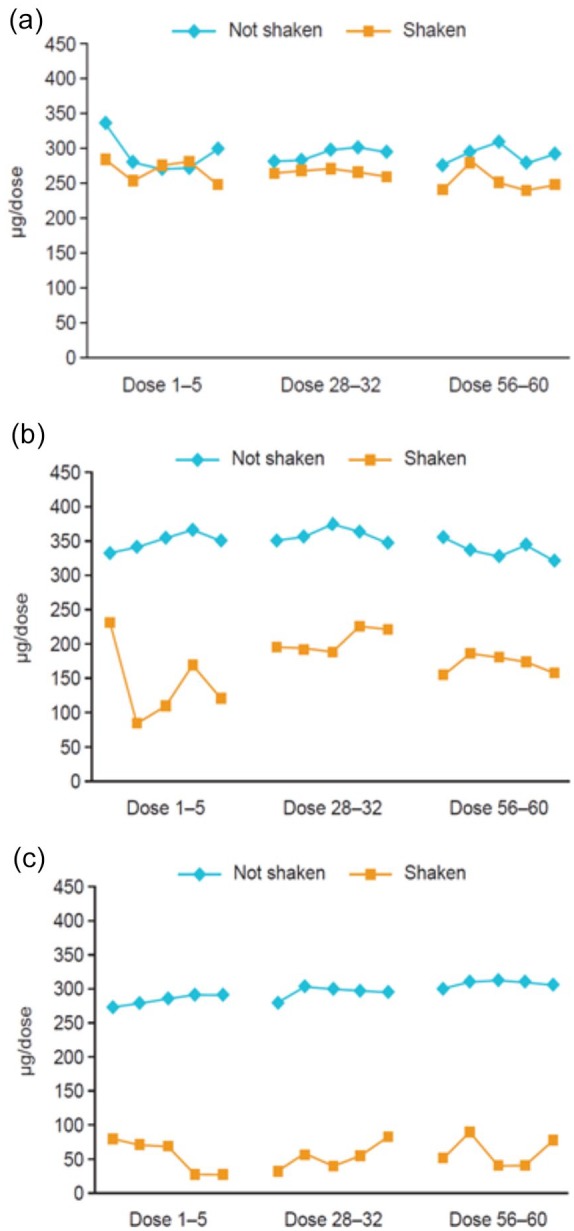
Mean delivered budesonide dose for (a) Turbuhaler®, (b) Easyhaler® and
(c) Spiromax® when the device was shaken and not shaken.31For each combination device of budesonide/formoterol, the expected
delivered dose of budesonide was 320 µg.